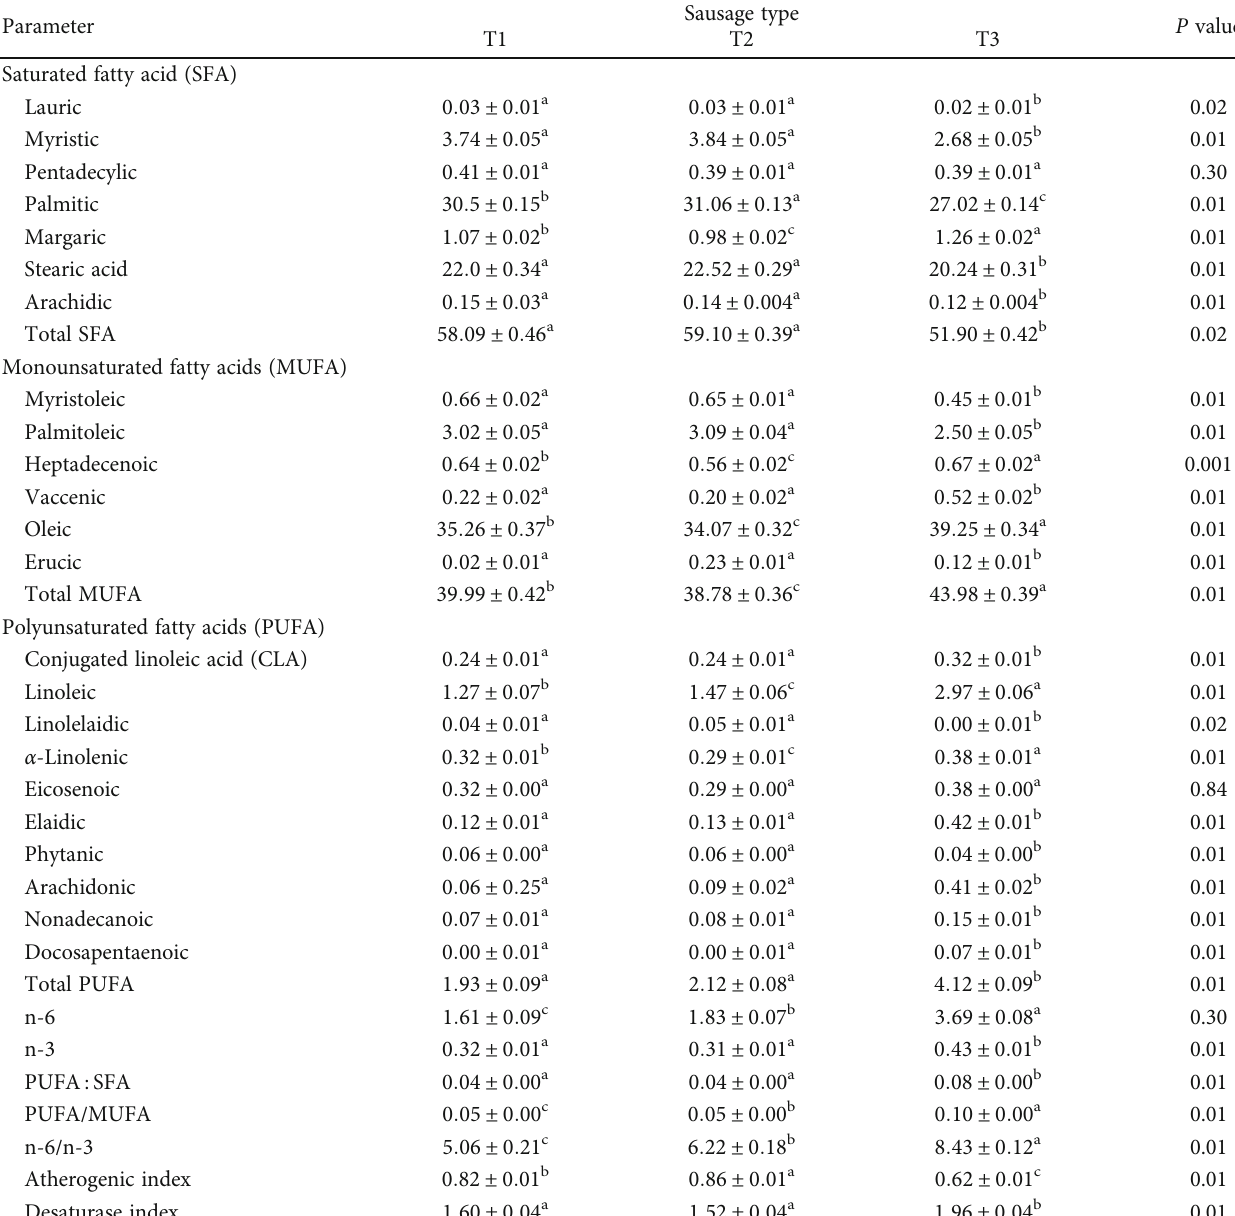
Table 3: Fatty acid composition of the raw beef sausage forti fi ed with edible animal